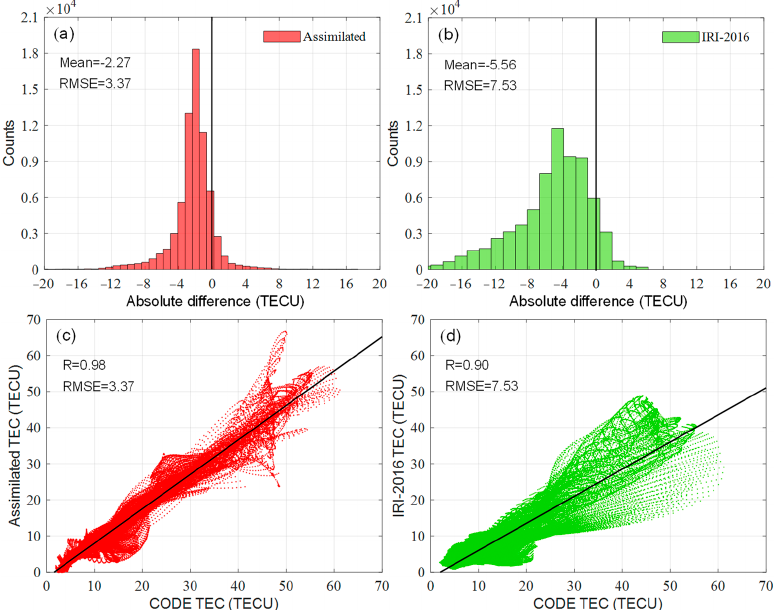
Figure 7. Distributions of absolute differences and TEC correlations on 8 September 2017. ( a ) Absolute differences between the assimilated TEC and the CODE TEC; ( b ) Absolute differences between the IRI-2016 TEC and the CODE TEC; ( c ) Assimilated TEC distribution versus the CODE TEC; ( d ) IRI-2016 TEC distribution versus the CODE TEC.